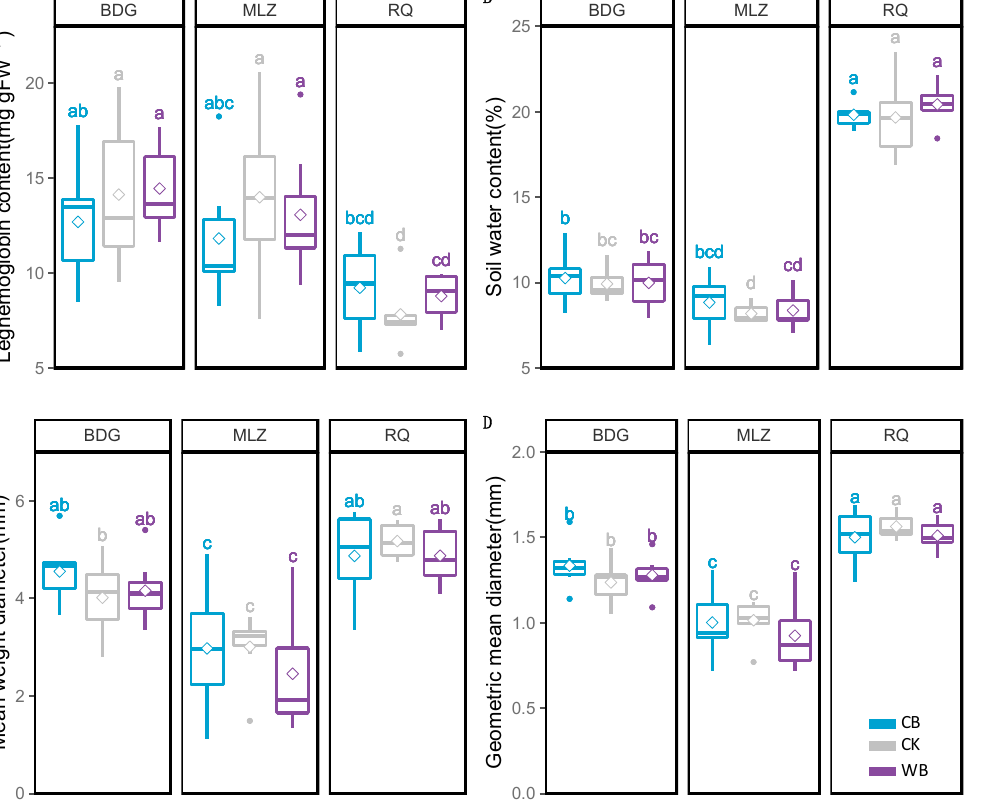
Figure 3. Effects of biochar on nodule leghemoglobin content ( A ), soil water content ( B ), mean weight diameter ( C ), and geometric mean diameter ( D ) in sandy clay loam (BDG and MLZ) and silty clay loam (RQ) soils. Error bars (standard error) followed by a different letter within each column are significantly different at p < 0.05 using the Duncan test.